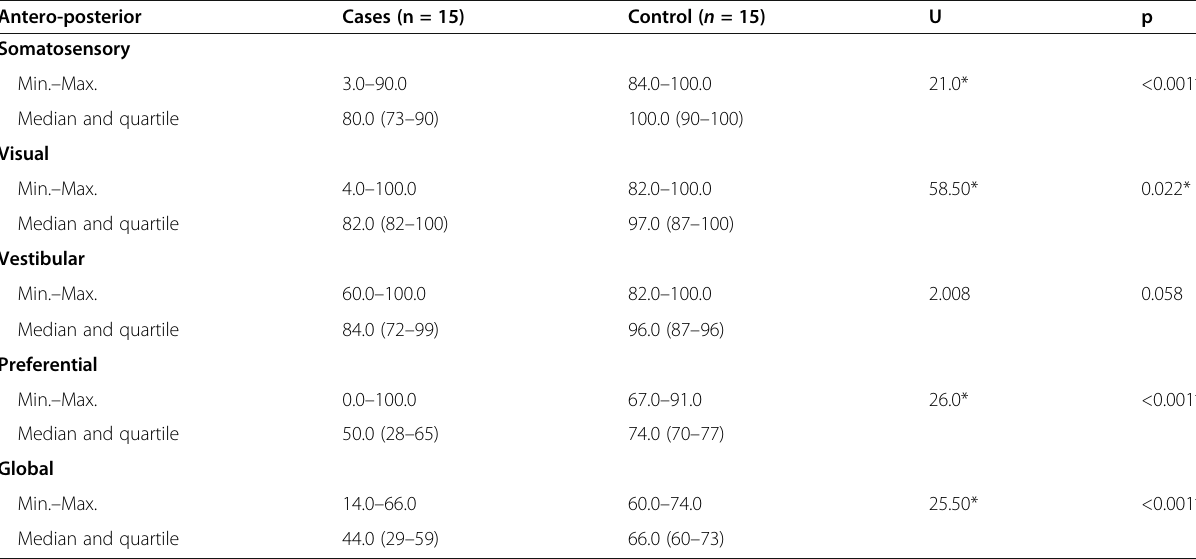
Table 2 Comparison of antero-posterior sensory balance scores of complete static sensory organization test between control and study groups ( n = 30)